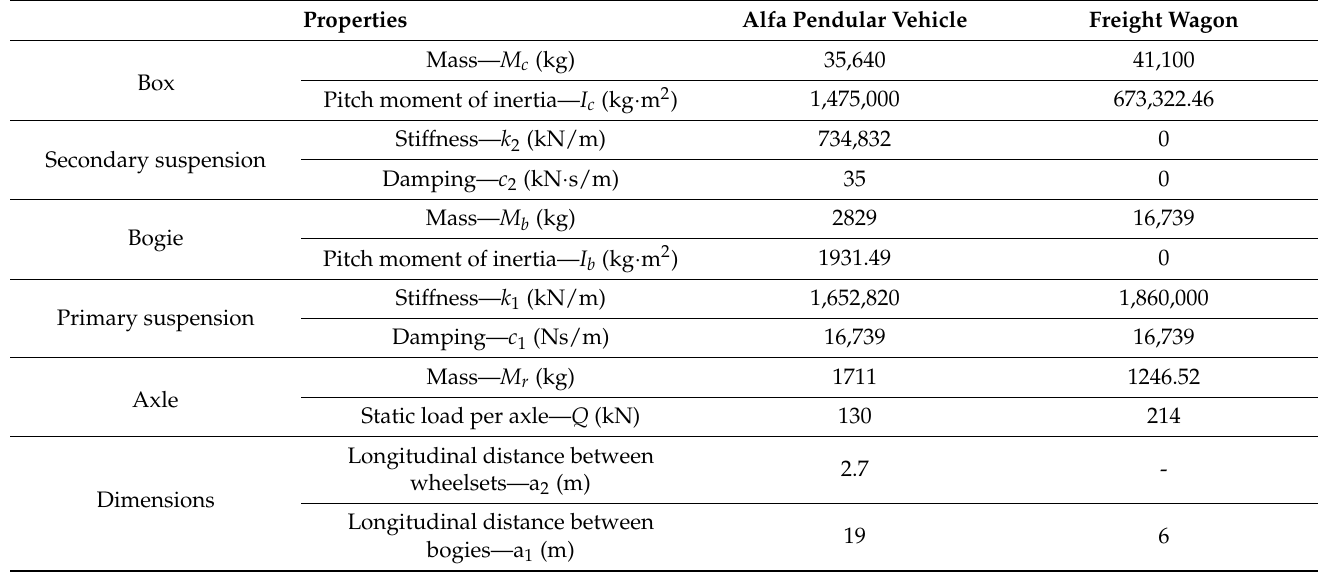
Table 2. Geometric and mechanical properties of the trains